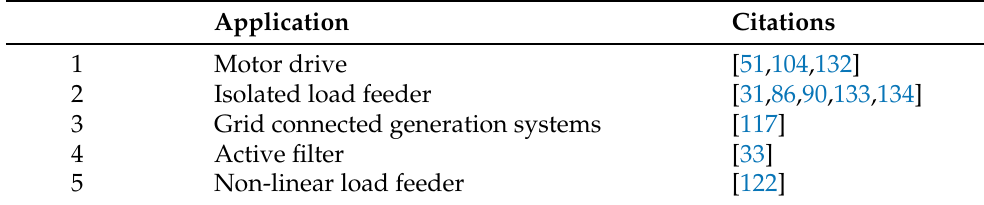
Table 2. DMC applications.